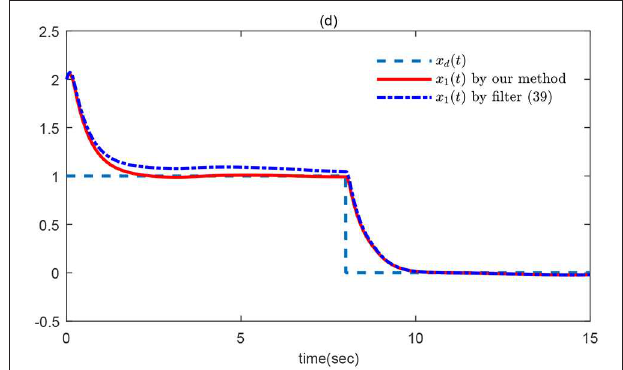
FIGURE 4 | Comparison